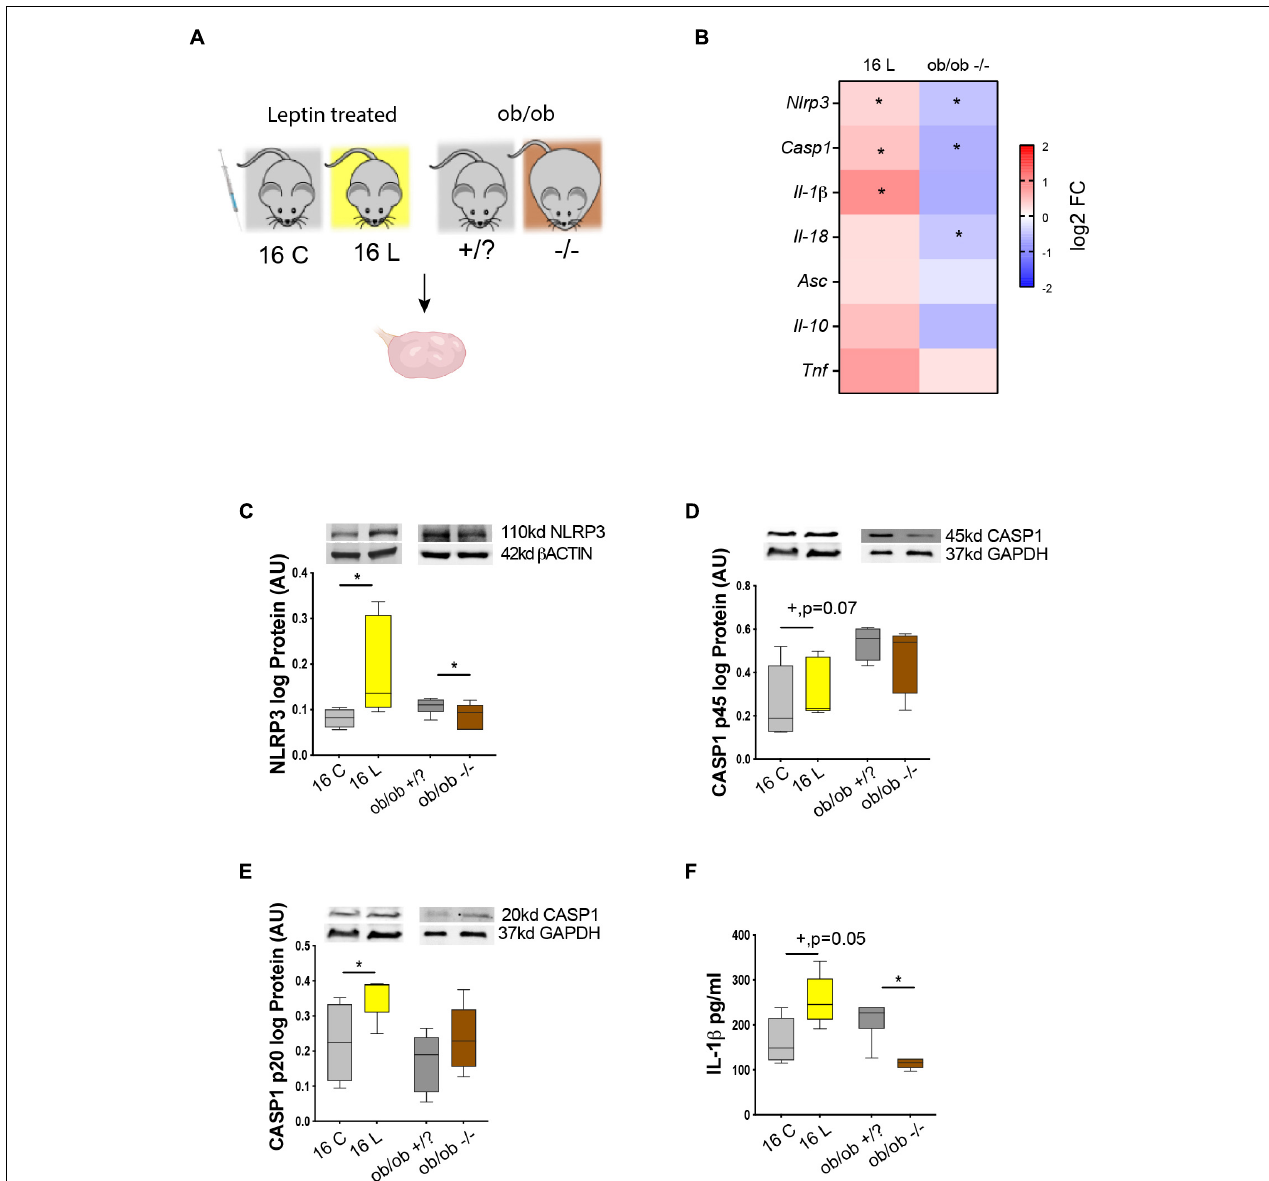
FIGURE 3 | Leptin signaling in the ovary drive changes in NLRP3 during obesity. (A) Experimental design: (i) pharmacological hyperleptinemic model, mice were either injected with saline or 100 µ g of leptin (L) for 16 days; (ii) genetic obesity model, mice lacking leptin ( ob/ob − / − ) or control group ( ob/ob +/?). (B) Heatmap illustrating fold of change in expression of mRNA of genes Nlrp3 , Casp1 , Il-1 β , Il-18 , apoptosis-associated speck-like protein-containing A CARD ( Asc ), Il-10 , and tumor necrosis factor alpha ( Tnf ) in hyperleptinemia and ob/ob models determined by real-time PCR. The scale matches colors to log 2 fold change (log2 FC) values. Abundance of (C) NLRP3, (D) pro CASP1 p45, (E) CASP1 p20 measured by Western blotting, and (F) IL-1 β quantified by ELISA, in the mouse ovarian extracts. Level mRNA normalized with ribosomal protein L37 ( Rpl37 ) value and protein expression with β -actin or glyceraldehyde 3-phosphate dehydrogenase (GAPDH). Bars represent mean ± SEM. Statistical analysis between groups was carried out using the Mann–Whitney test. Number of samples: n = 6–8 for real-time PCR analysis, n = 6–8 for immunoblots and n = 4–5 for ELISA. Asterisks indicate significant differences (* p < 0.05; + p = 0.07). AU, arbitrary